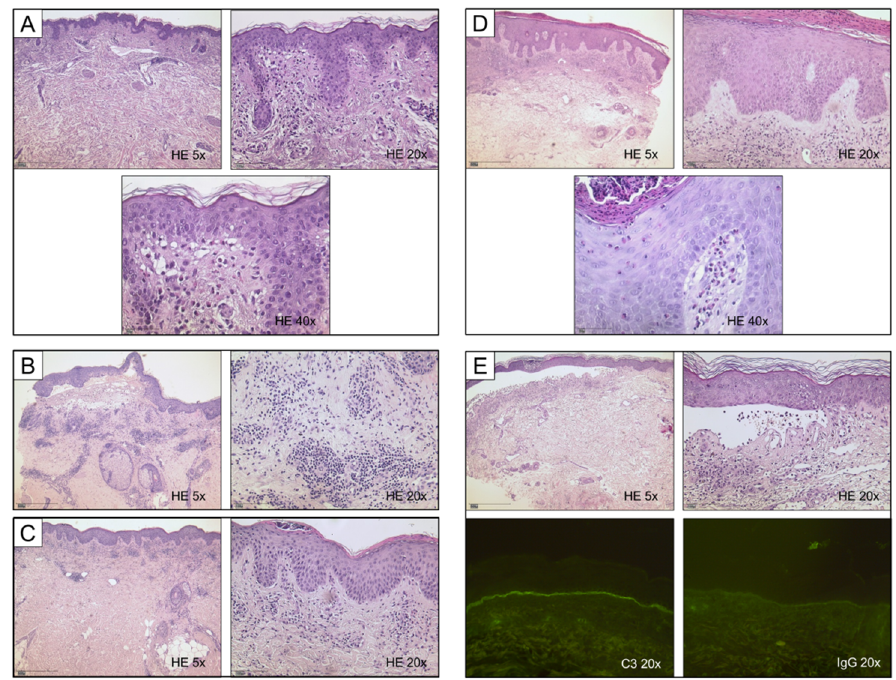
Figure 2. Histological synopsis of different manifestations of bullous pemphigoid; cases correspond to Figure 1. ( A ) Unremarkable epithelium, yet abundant eosinophils and marked papillary edema. ( B ) Fully developed subepidermal blister containing numerous eosinophils and erythrocytes; note a remarkably dense perivascular lymphocytic infiltrate. ( C ) Superficial perivascular dermatitis with psoriasiform hyperplasia and marked parakeratosis; subcorneal neutrophils are testimony of previous scratching which resulted in ulceration. ( D ) Histologic features of both psoriasis (acanthotic epidermis with hypogranulosis and compact parakeratosis) and marked tissue eosinophilia, note eosinophilic spongiosis. ( E ) Fully developed subepidermal blister with predominance of neutrophils; note intracorneal pustule in the detached epidermis. Immunofluorescence confirmed diagnosis of BP in the respective patients. Linear deposits of C3 and immunoglobulins are the prerequisite diagnostic criterion for BP, especially with unusual clinical appearance.